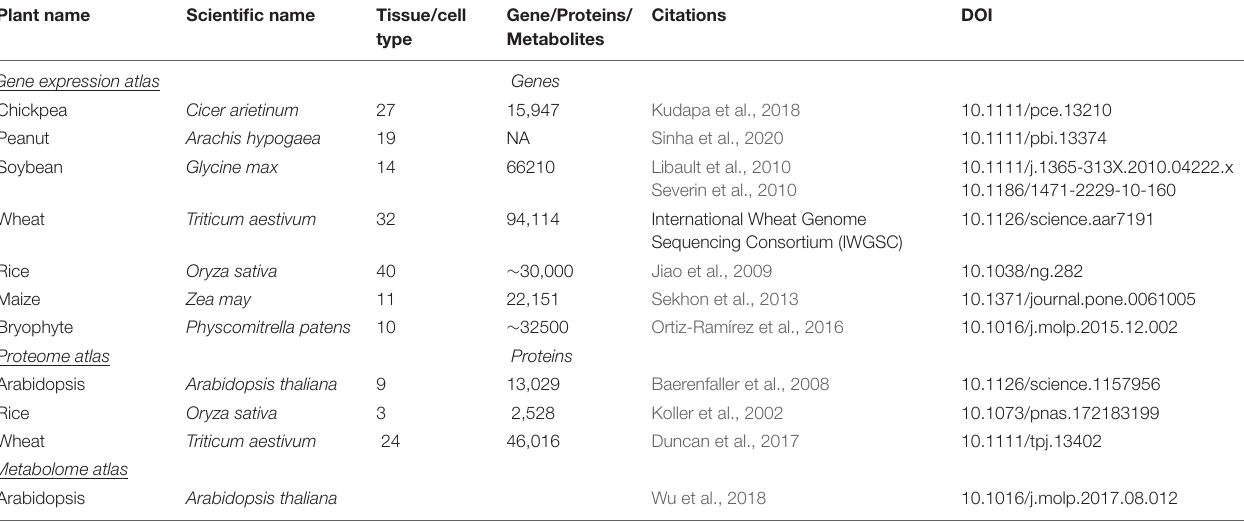
TABLE 3 | List of gene-expression, proteome and metabolome atlas developed in